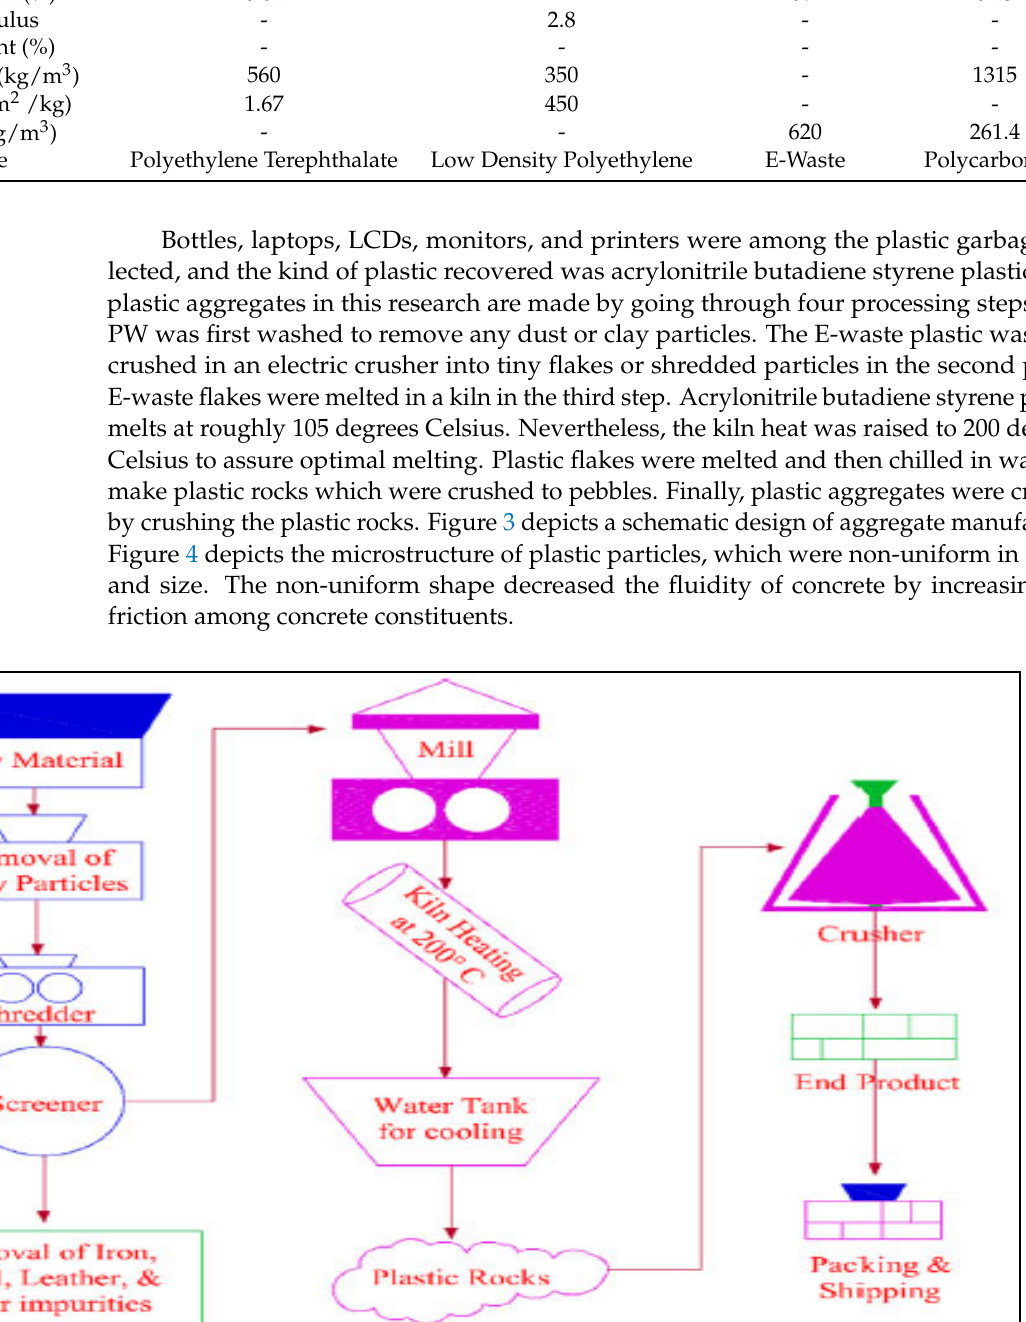
Table 1. Properties of Plastic Waste (PW) Used in concrete.